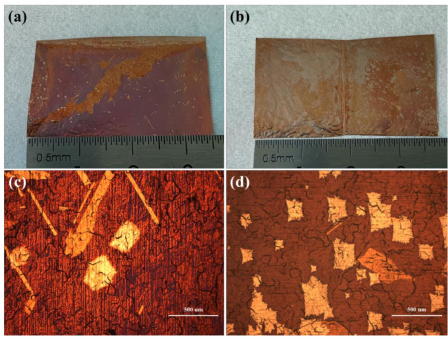
Figure 5. ( a , b ) Optical picture of the back of the copper pockets (outer surfaces) at location 2 and location 4 after oxidation treatment. ( c , d ) Optical micrograph of the back of the copper pockets (outer surfaces) at location 2 and location 4 under 50-times